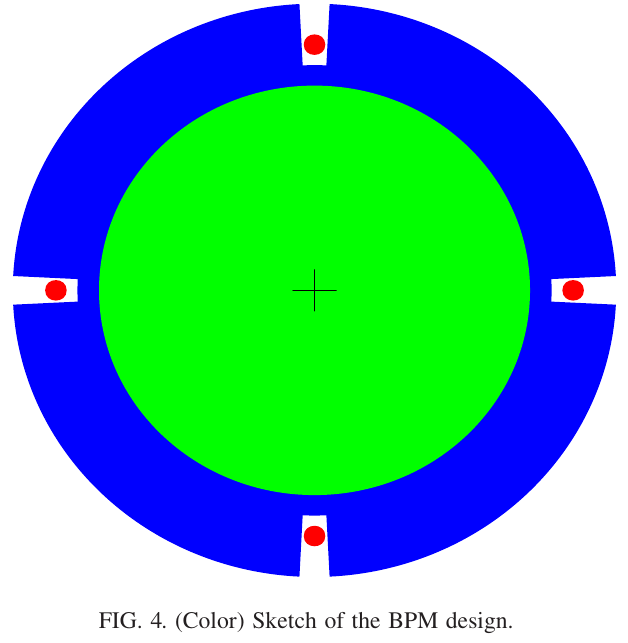
FIG. 4. (Color) Sketch of the BPM